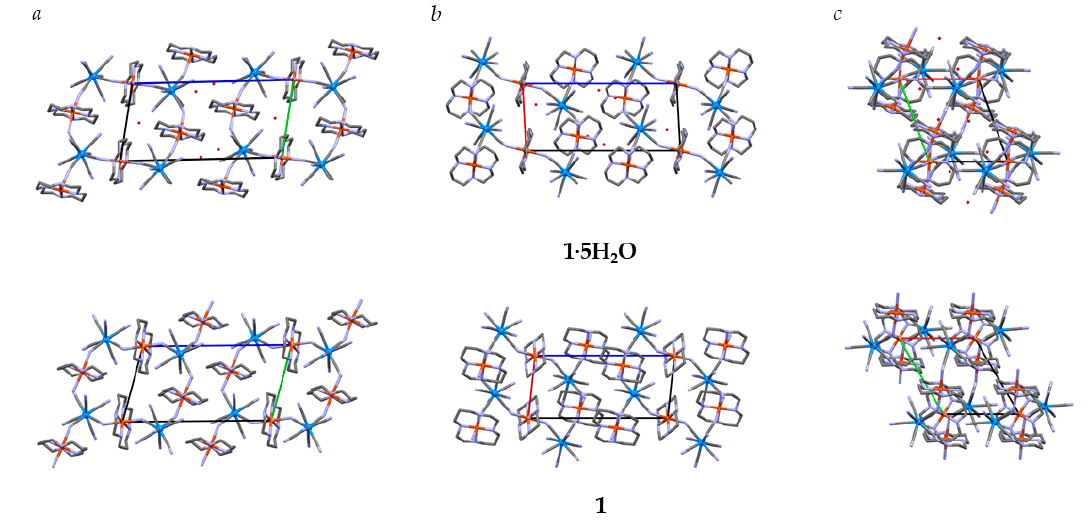
Figure 2. Projection of structures of 1 · 5H 2 O and 1 along ( a – c ) crystallographic directions. The 0D {[Cu II (cyclam)(H 2 O)] 2 [Cu II (cyclam)][W V (CN) 8 ] 2 } . 3H 2 O assembly ( 2 · 3H 2 O ) is obtained